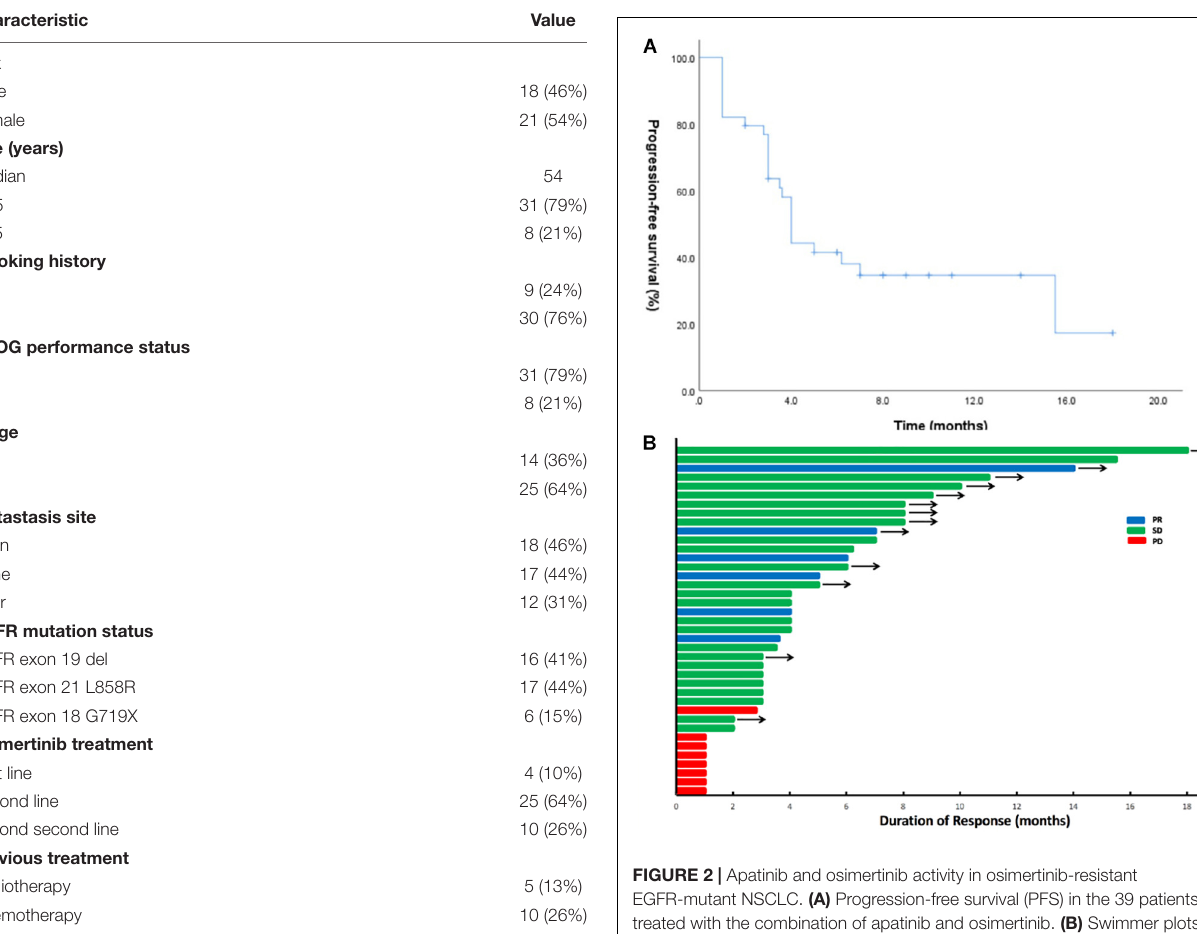
TABLE 1 | Baseline clinical features of patients enrolled in the study ( n = 39).